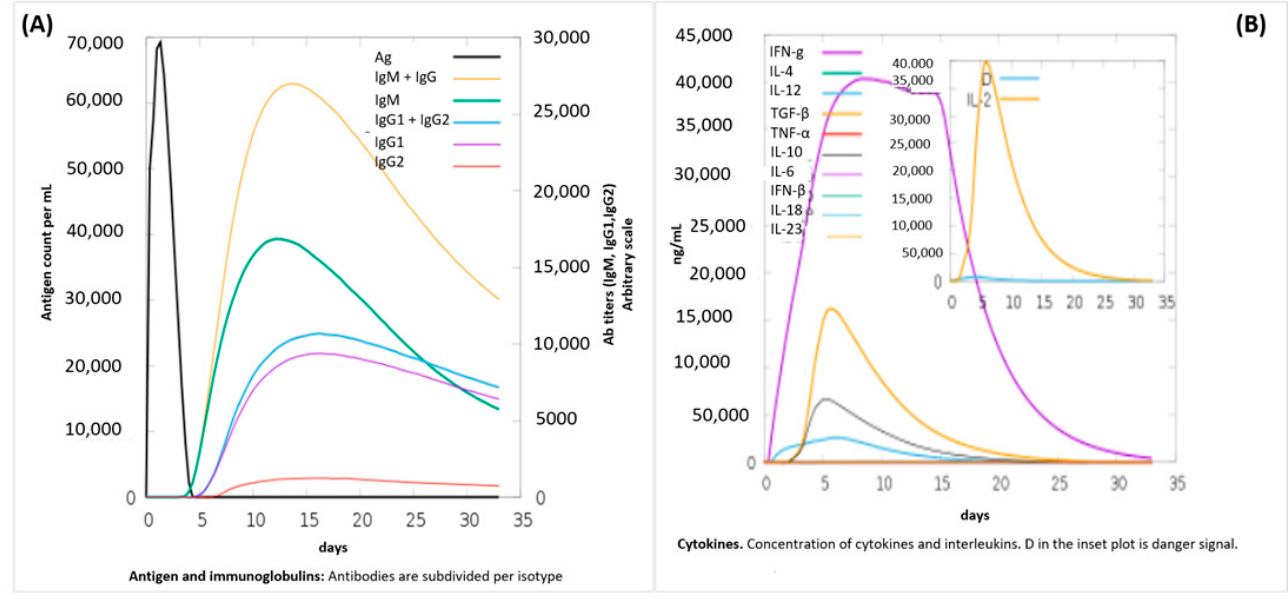
Figure 6. In-silico simulation of immune response using the vaccine as an antigen to generate a robust immune response. ( A ) Representation of antigen and immunoglobulins in immune response. ( B ) Representation of cytokines in immune response.